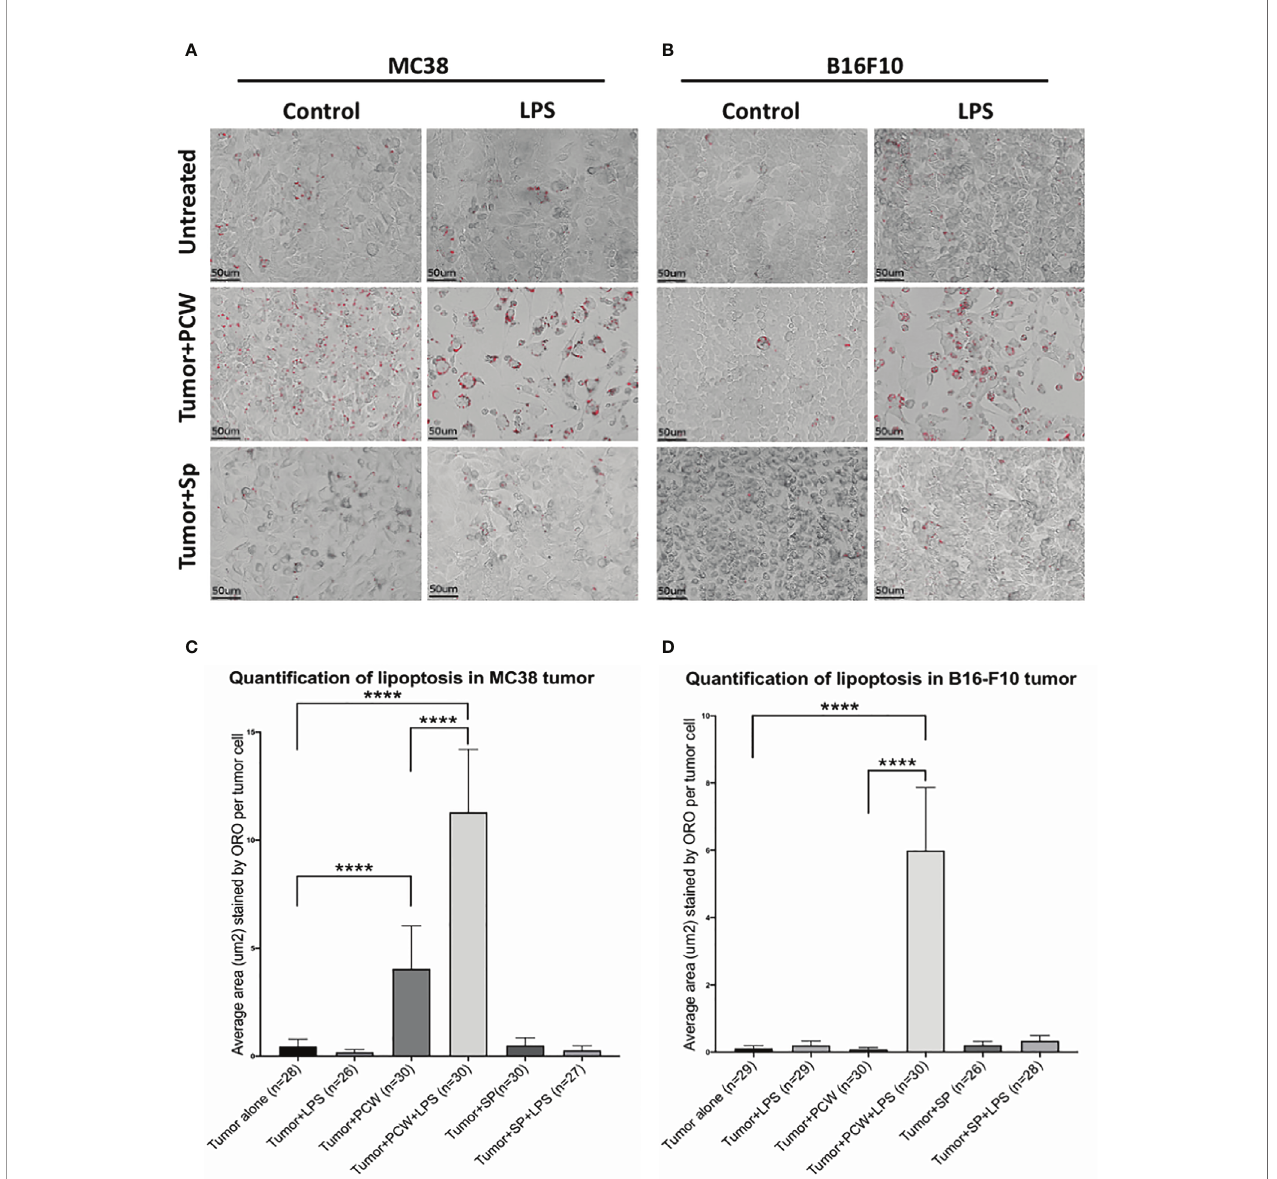
FIGURE 4 | L2pB1 cells are essential for PCW-induced lipoptosis of melanoma cells. (A) MC38 colon cancer cells and (B) B16F10 melanoma cells were cultured alone, or co-cultured with PCW cells or splenocytes for 72 hours in the presence and absence of LPS. Oil Red O staining was performed at 72 hours. Scale bar (red) = 50 m m. Representative images from triplicate wells were taken at 400x magni fi cation. (C) Oil Red O intensity analysis of MC38 cells co-culturing with PCW cells in the presence or absence of LPS. There is signi fi cant difference between cancer cell alone and cancer cells in the presence of PCW cells (****p value <0.0001). Stimulation of PCW cells with LPS during co-culture induced signi fi cantly greater amount of lipoptosis as compared to that in the absence of LPS (****p value <0.0001). (D) Oil Red O intensity analysis of B16F10 cells lipoptosis. The intensity was signi fi cantly increased upon co-culture with PCW cells in the presence of LPS (****p value